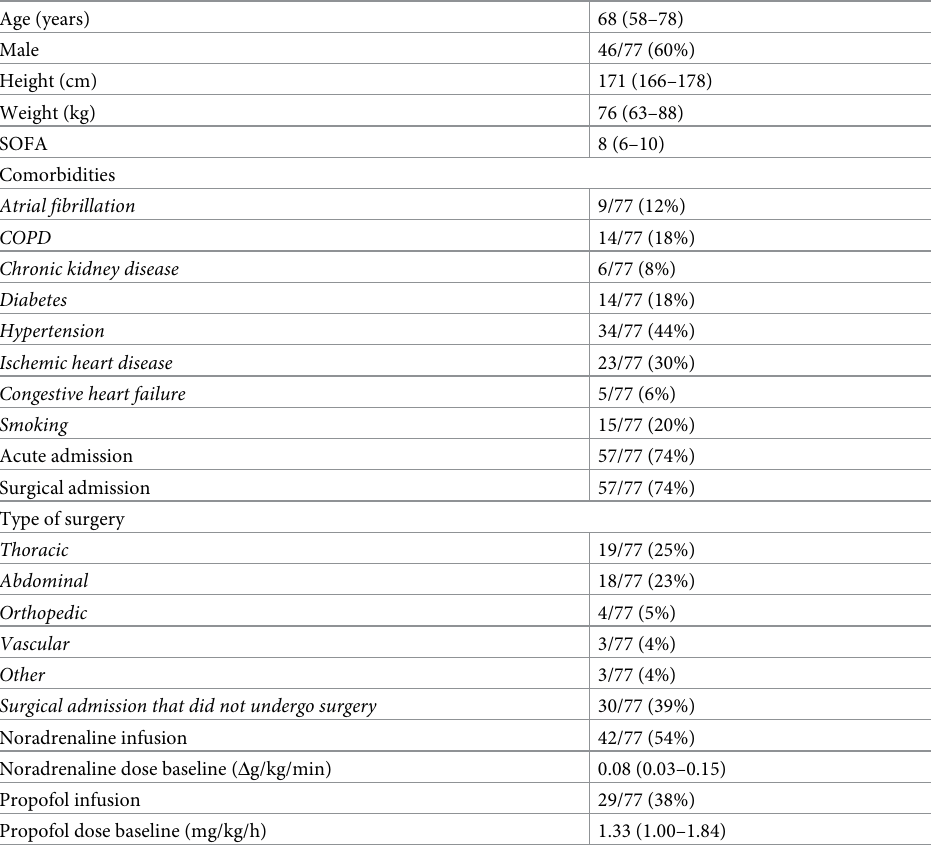
Table 1. Patient